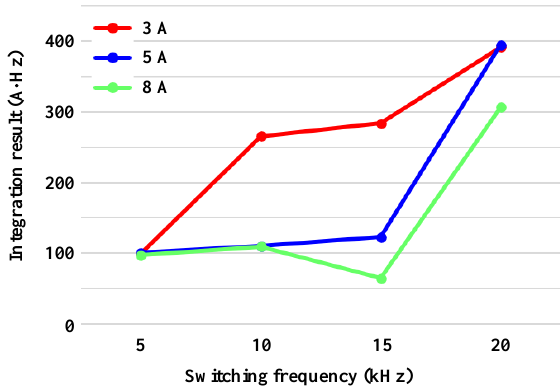
Figure 5. Integral results from 5 kHz to 40 kHz for Figure 4.